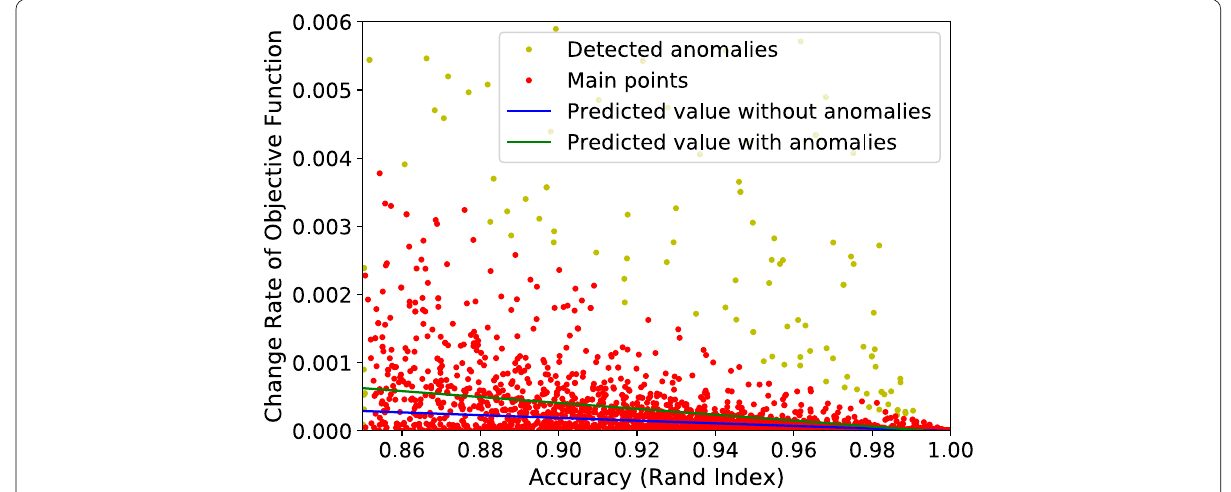
Fig. 4 Relation between change rate of objective function and